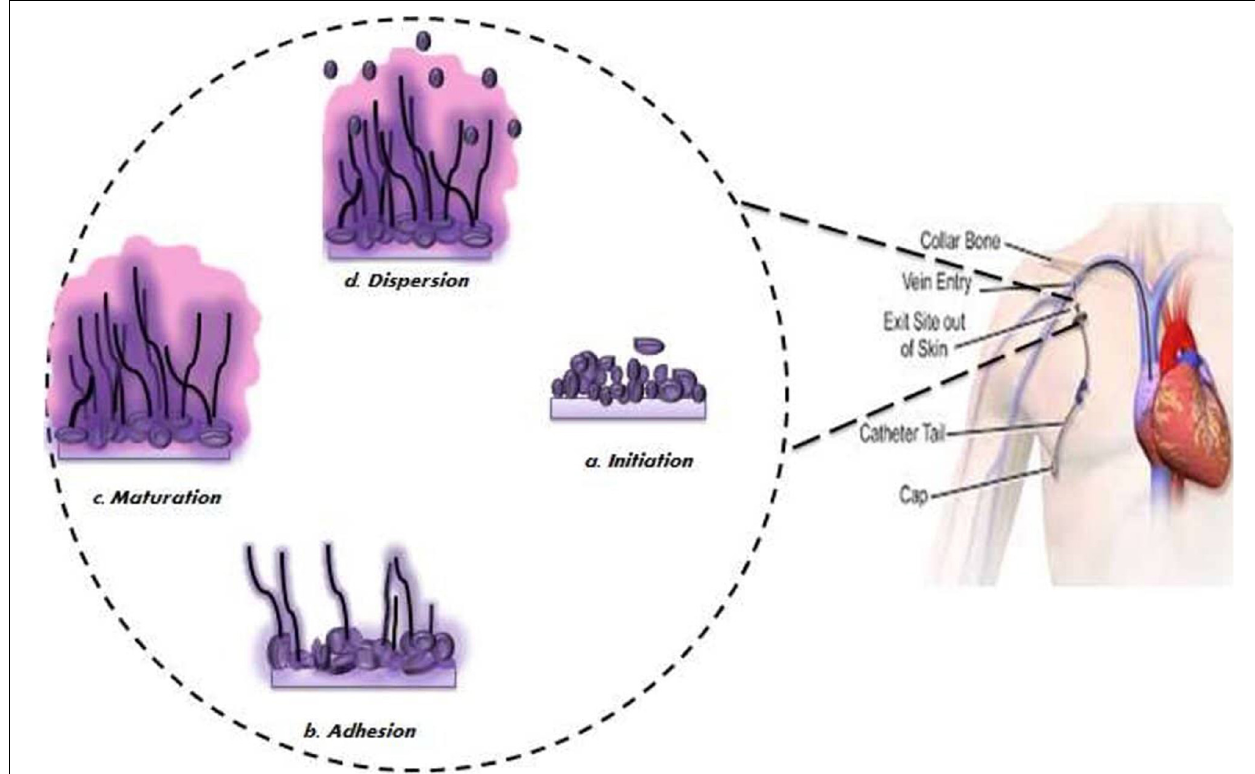
FIGURE 2 | Schematic diagram of different stages of biofilm development.